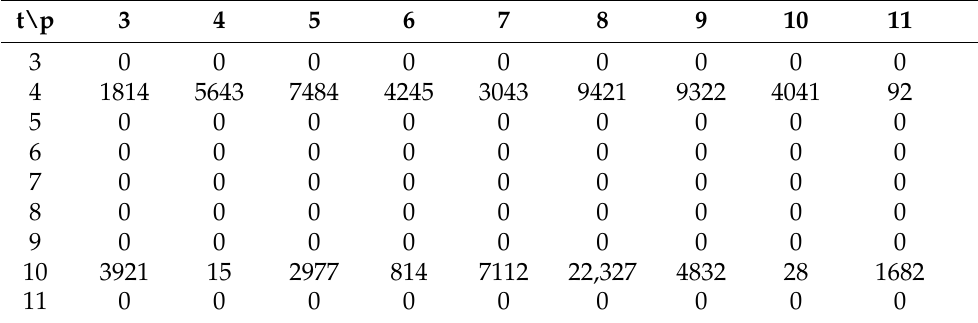
Table 12. The confusion matrix for SPPB of participant 16. The only class with correct predictions is class 4. t = true label, p = predicted label.